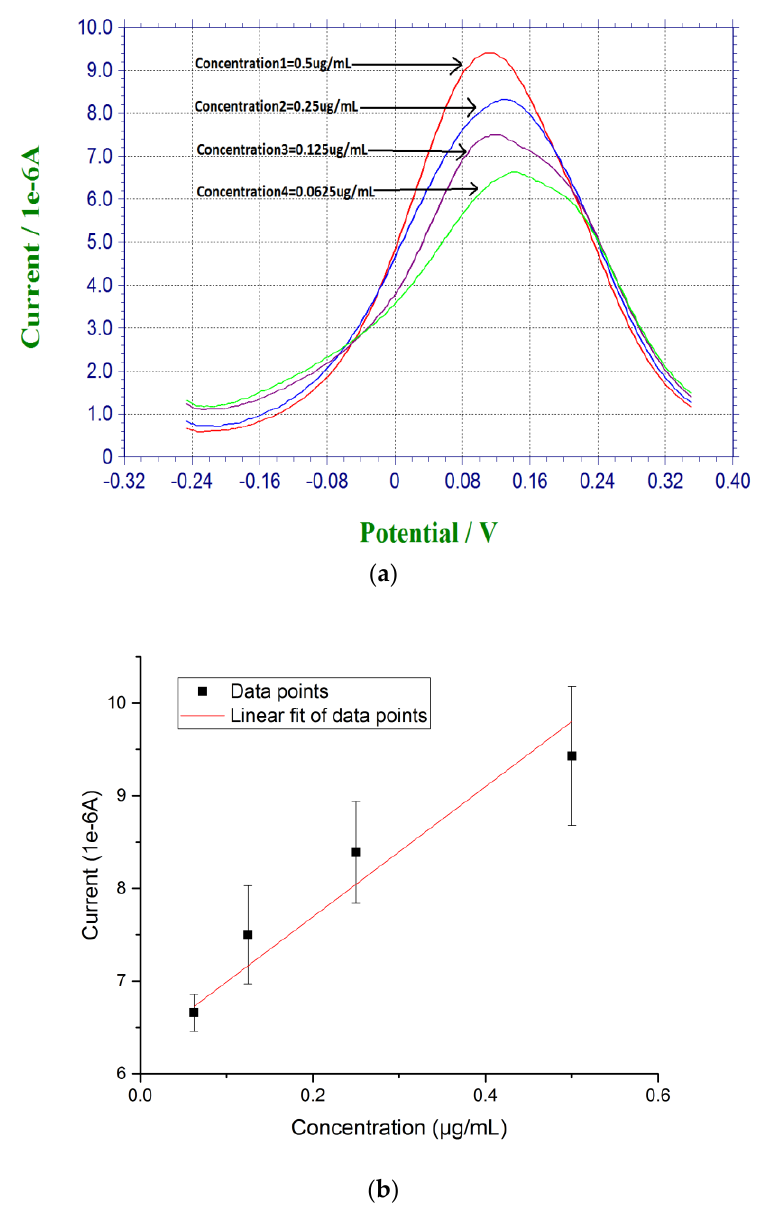
Figure 2. ( a ) DPV measurement of β-amyloid 42 antigens with concentrations ranging from 0.0675 µg/mL to 0.5 µg/mL in PBS; and ( b ) Calibration curve based on the DPV measurement of β-amyloid 42 in PBS ( n = 3).